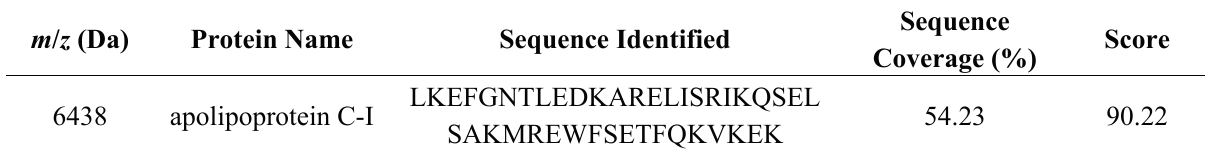
Table 3. Protein or peptide segments with m / z values of 6438 Da in the target